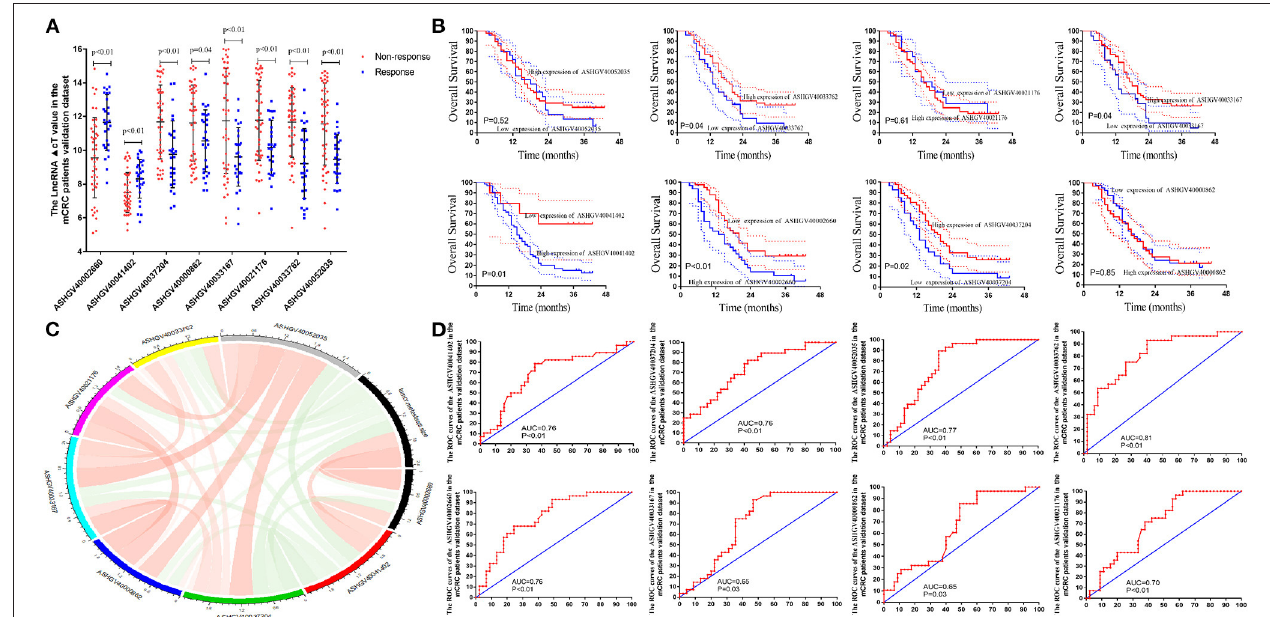
FIGURE 6 | External validation of hub long non-coding RNAs (lncRNAs) in metastatic colorectal cancer (mCRC) patients. (A) The hub lncRNAs 1 Ct value in the chemotherapy-sensitive and chemotherapy-resistance tissue in external mCRC patients by quantitative PCR (qPCR) (all P < 0.01). (B) Correlation analysis between the hub lncRNAs expression and tumor response to FOLFOX chemotherapy. (C) The Kaplan–Meier analysis for the overall survival of the hub lncRNAs in mCRC patients. (D) Receiver operating characteristic (ROC) analysis to evaluate the predictive efficiency of the hub LncRNAs in mCRC patients for FOLFOX chemotherapy. TABLE 1 | Cox regression analysis of eight long non-coding RNAs (lncRNAs) for disease-free survival and overall survival in colorectal cancer (CRC) patients ( n = 136). Disease free survival Overall survival Variables Multivariate analysis Multivariate analysis P